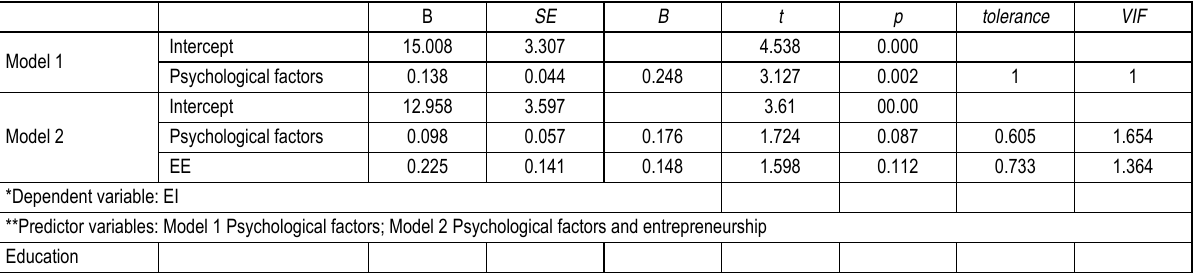
Table 5. Summary of hierarchical multiple regression analysis test results